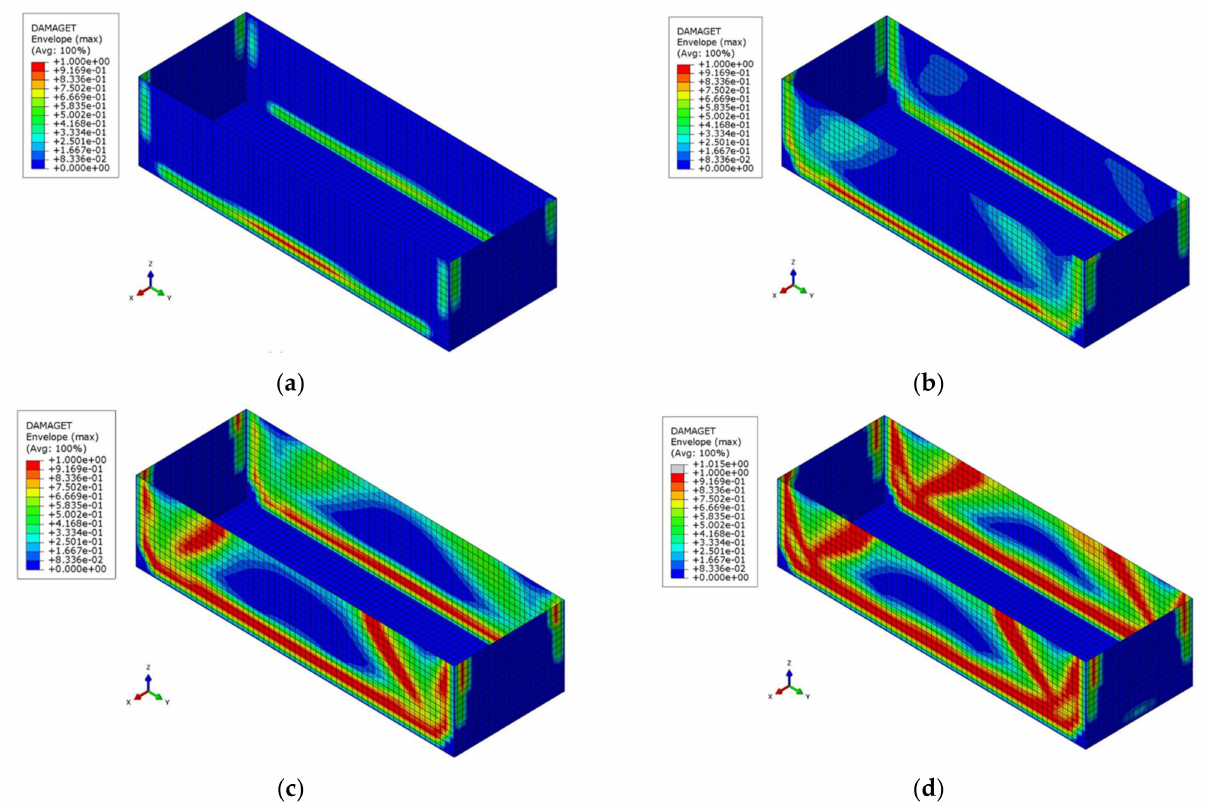
Figure 18. Tensile damage variable d t when the incident angle of the input ground motion is 140 ◦ : ( a ) 1.20 s; ( b ) 1.75 s; ( c ) 2.30 s; ( d ) 24.61